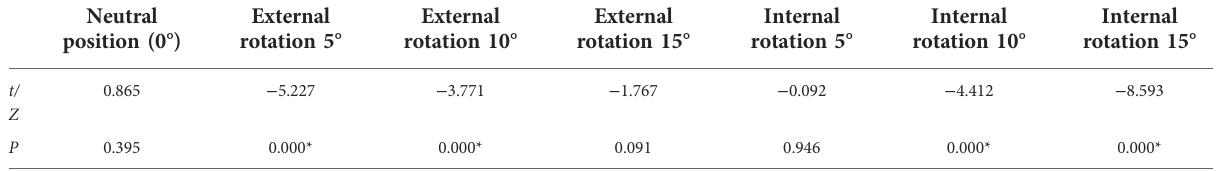
TABLE 5 Comparison of contact stresses between medial and lateral femoral – tibial side under 600